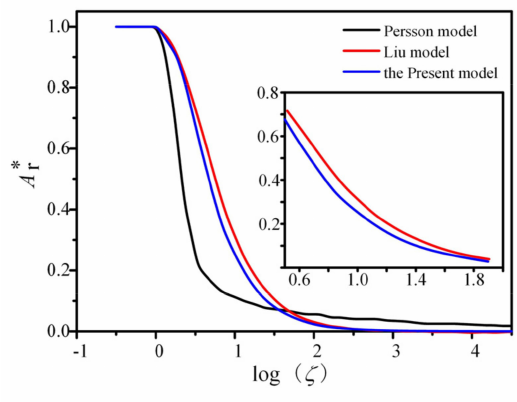
Figure 12. Comparison between models.